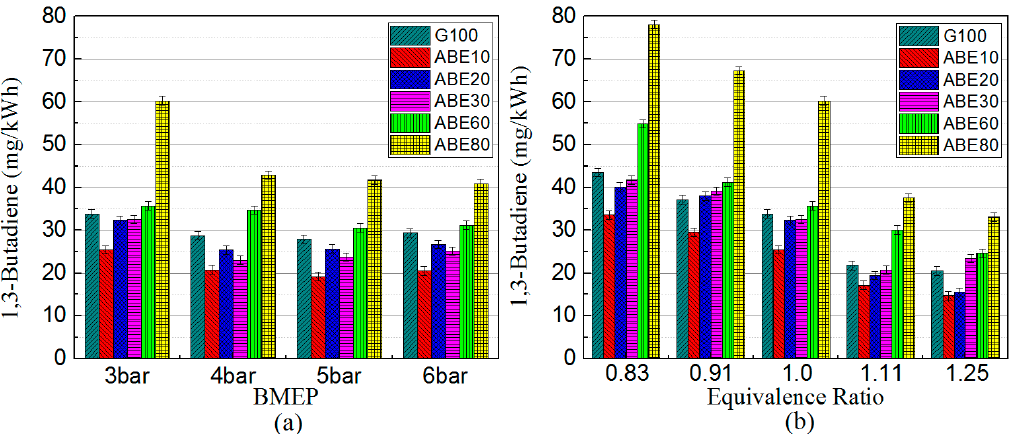
Figure 6. 1,3-Butadiene emissions at ( a ) stoichiometric conditions under different BMEP, and at ( b ) 3 bar BMEP under different equivalence ratios.